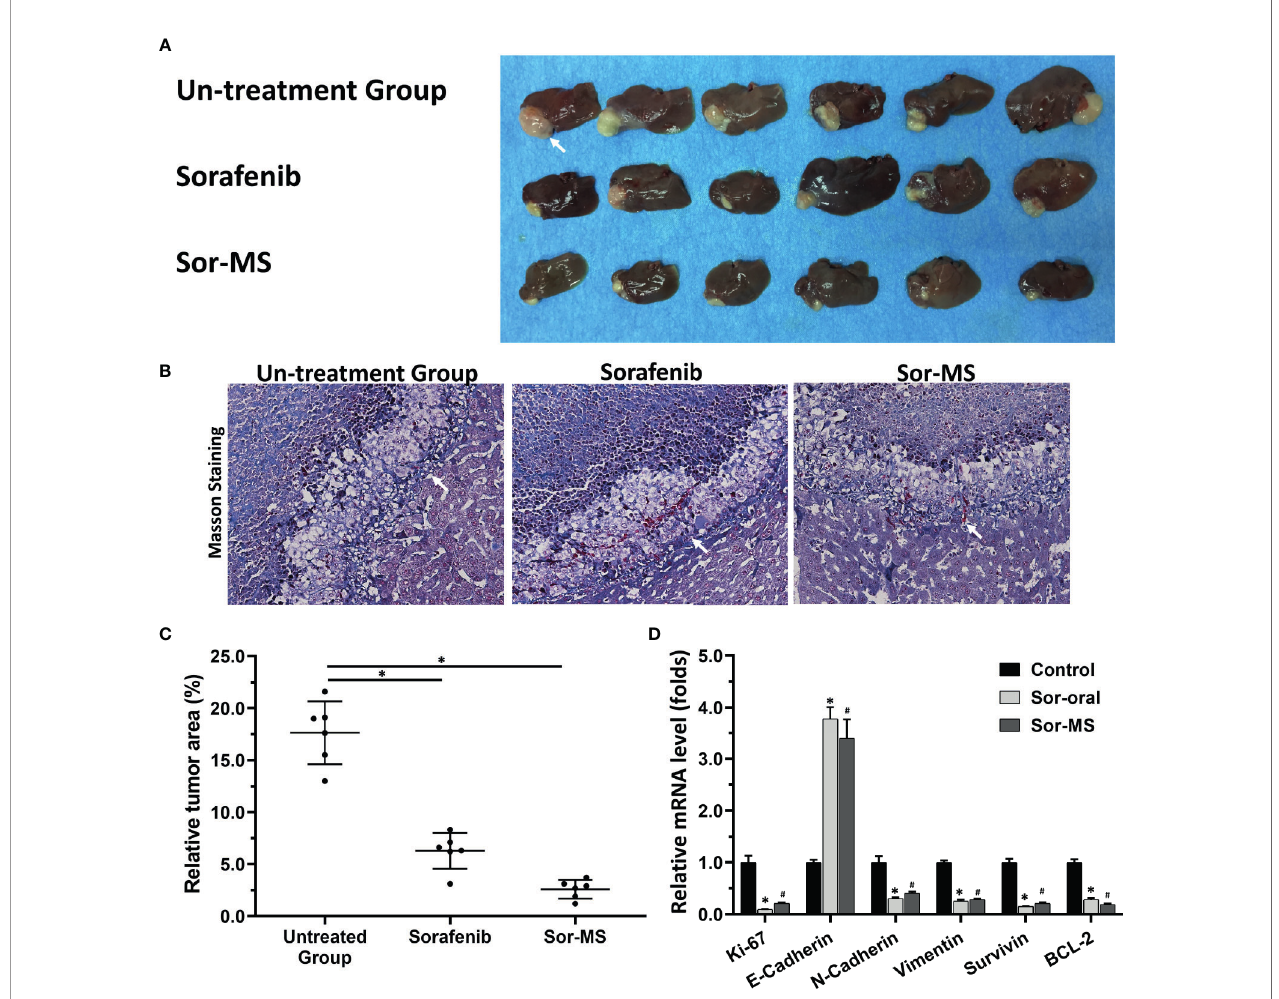
FIGURE 3 | Antitumor activation of sorafenib formulations in an intrahepatic tumor model of immunode fi cient rats. MHCC97-H cells were cultured, and the intrahepatic lesions of hepatocellular carcinoma (HCC) were established in the live organs of immunode fi cient rats. Rats received one intratumor injection (50 m l amount) of sorafenib microcrystal formulation with the largest particle-size (Sor-MS) (30mg/ml) or sorafenib via oral administration (2mg/kg concentration, repeatedly over a long period of time). Results are shown as images of rats ’ liver organs with lesions formed by MHCC97-H cells (A) , the relative total area of the lesions (C) , and the expression level of proliferation-related factors in the tissues (D) . (B) the images from masson staining results indicated the boundary between rat liver tissue and the intrahepatic lesions. *P < 0.05 versus untreated group (Sor-Oral group); # P < 0.05 versus untreated group with Sor-MS group. The write arrow indicated the intrahepatic